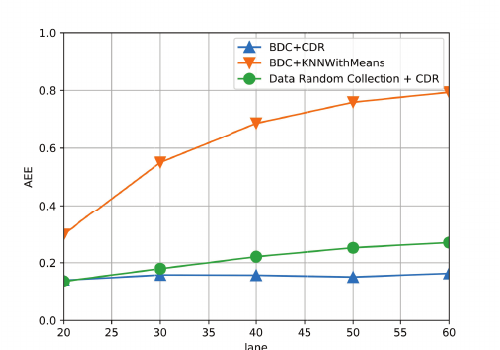
Figure 11. The AEE of three algorithms under different numbers of covered road segments.